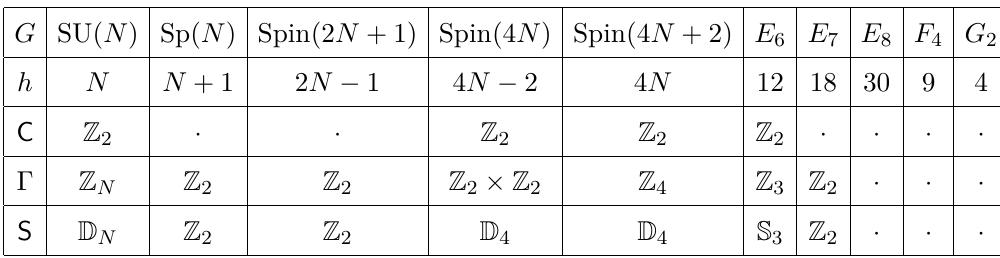
Table 1 . Lie data for the simple Lie groups G . Here h denotes the dual Coxeter number (defined as tr( t ) ≡ 2 h ( t, t 0 ) , where ( · , · ) denotes the Killing form on g , normalized so that the highest 0 adj t adj root has ( θ, θ ) = 2 ). C , Γ are the zero-form and one-form symmetry groups of 4 d N = 1 SYM with gauge group G , and S = Γ o C . D denotes the dihedral group with 2 N elements, and S N the symmetric group with N ! elements. For SU(2) the zero-form symmetry group is trivial, and for Spin(8) the zero-form symmetry group is enhanced to S and the total symmetry group to S 3 D symmetry of pure SU( N ) YM was considered in N